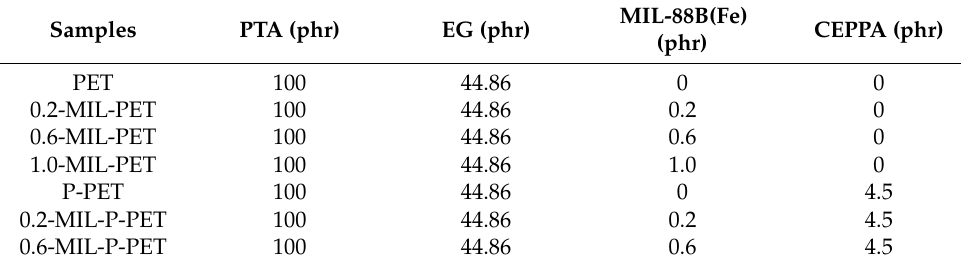
Table 1. The recipes of MIL-88B(Fe) and PET